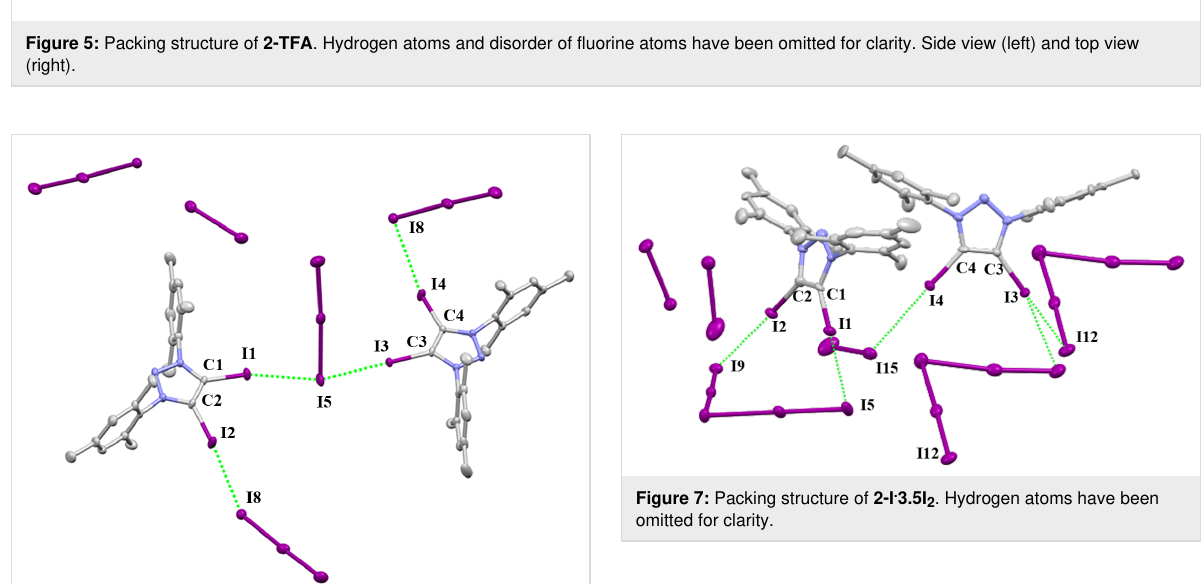
calculations (Figure 9). The calculation results show that σ holes in diiodotriazolium D are mainly located in the elonga- tion of two C–I bonds. The DFT calculation also shows that